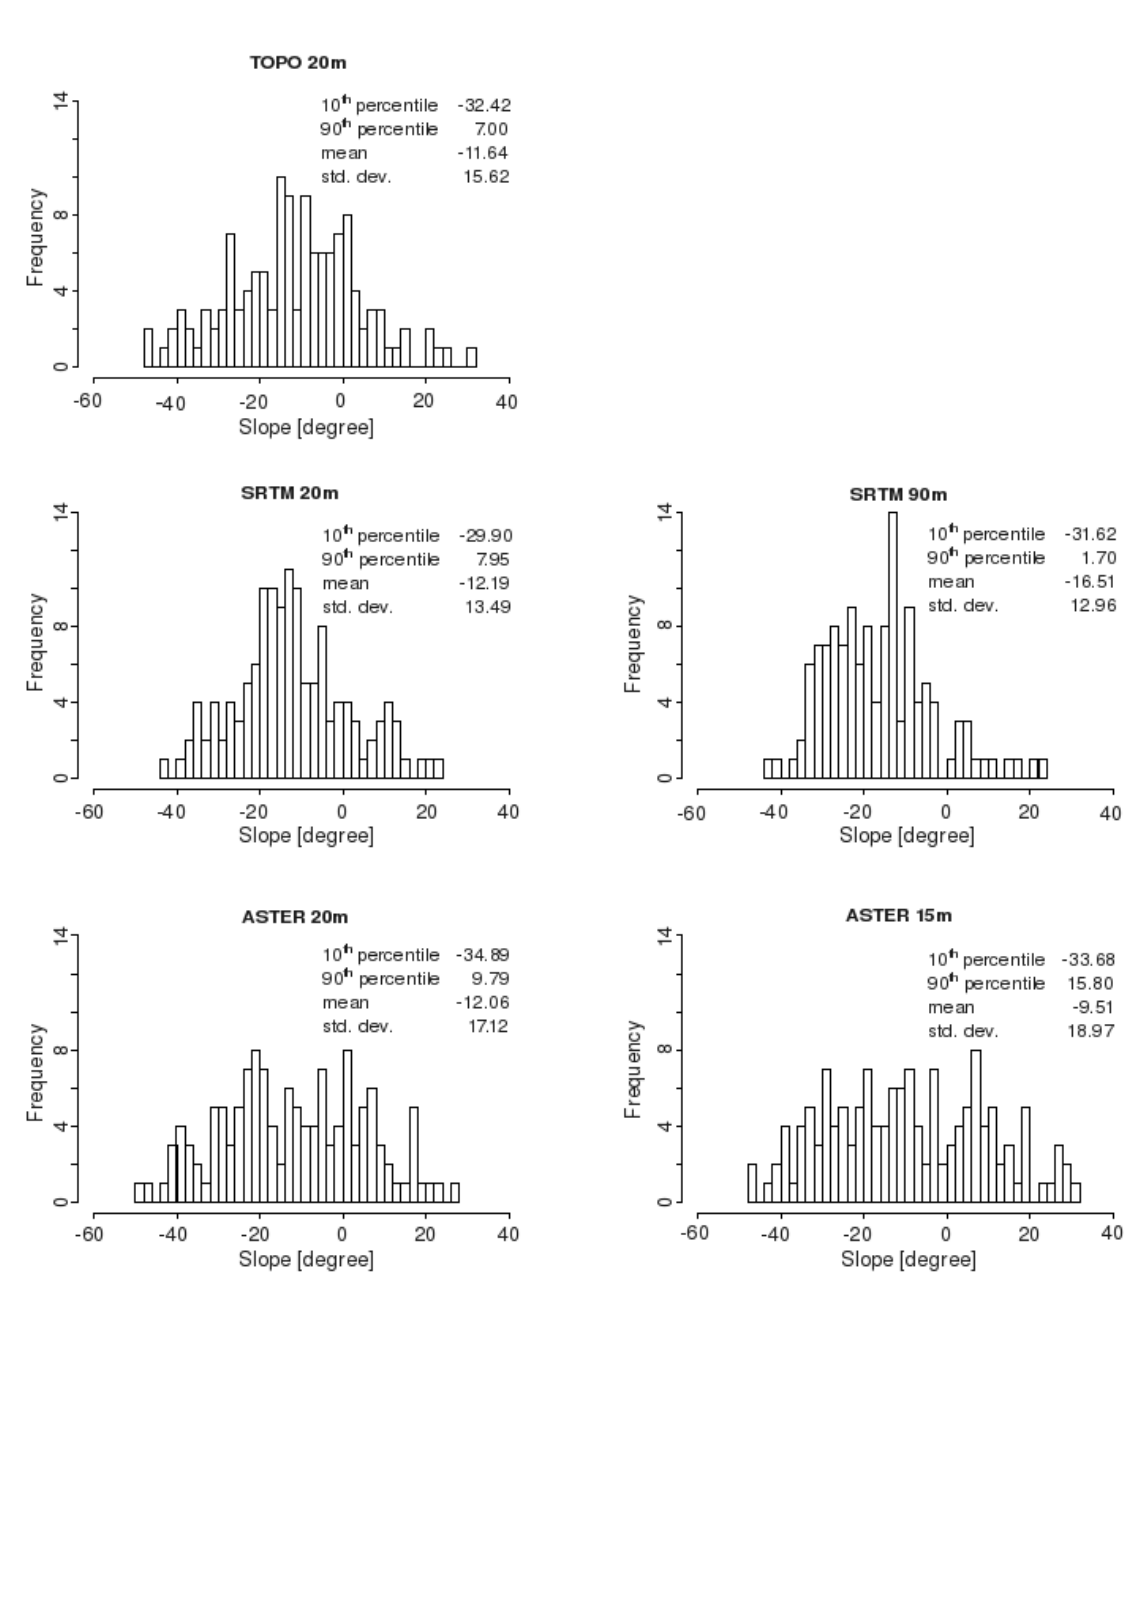
Figure 5. Slope error frequency, mean error, standard deviation and error percentile for the five DEMs (errors calculated by subtracting field measured slopes from the DEM derived